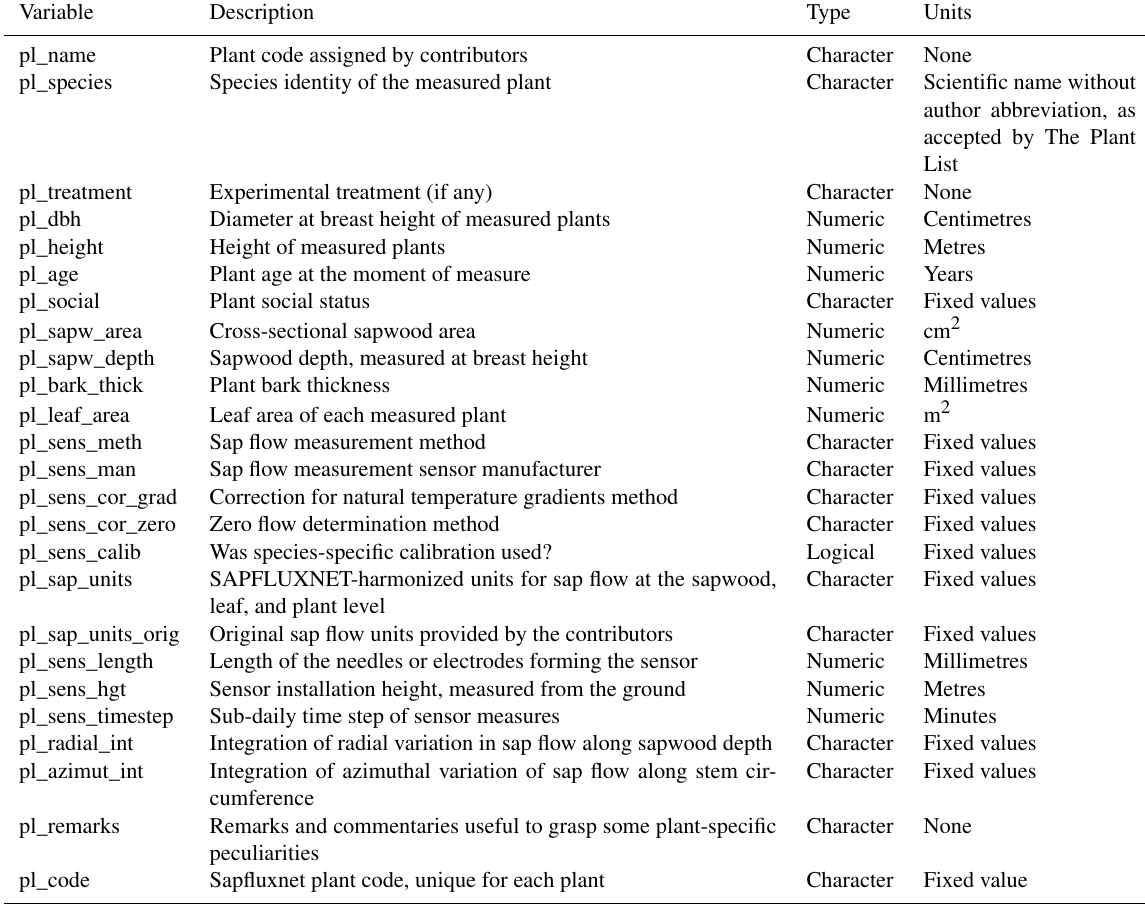
Table A5. Description of plant metadata variables in SAPFLUXNET